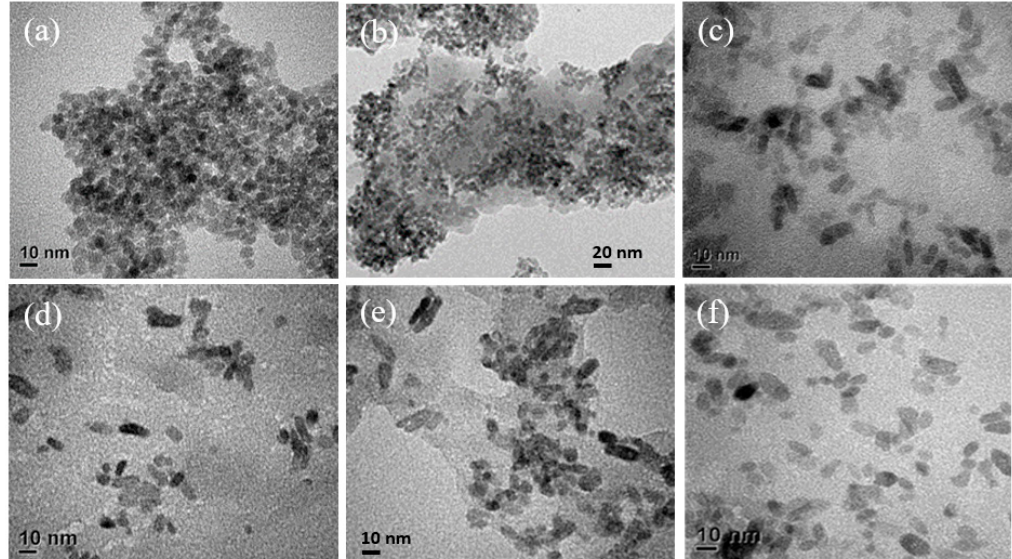
Figure 3. TEM images of: ( a ) TiO 2 ; ( b ) Ti / uCN_0.25; ( c ) Ti / uCN_0.5; ( d ) Ti / uCN_1; ( e ) Ti / uCN_1.5; and ( f ) Ti / uCN_2.